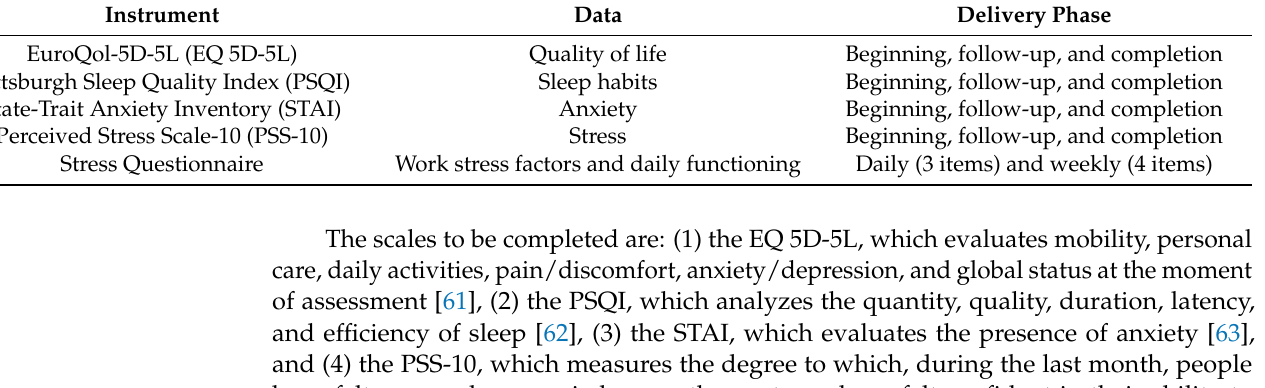
Table 1. Measuring assessment tools.